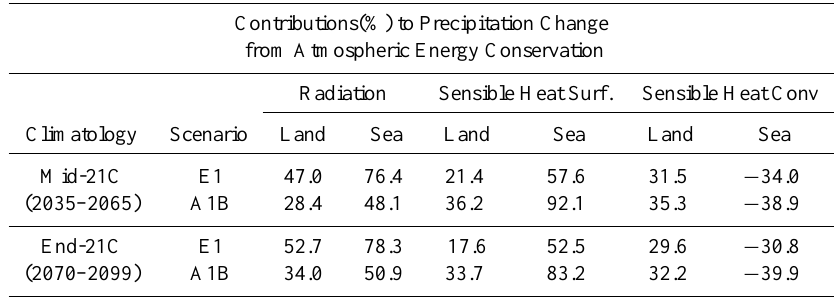
Table 3. Same as Table 2 but for contributions to rainfall coming from (left) atmospheric radiation, (middle) surface sensible heat flux and (right) atmospheric sensible-heat